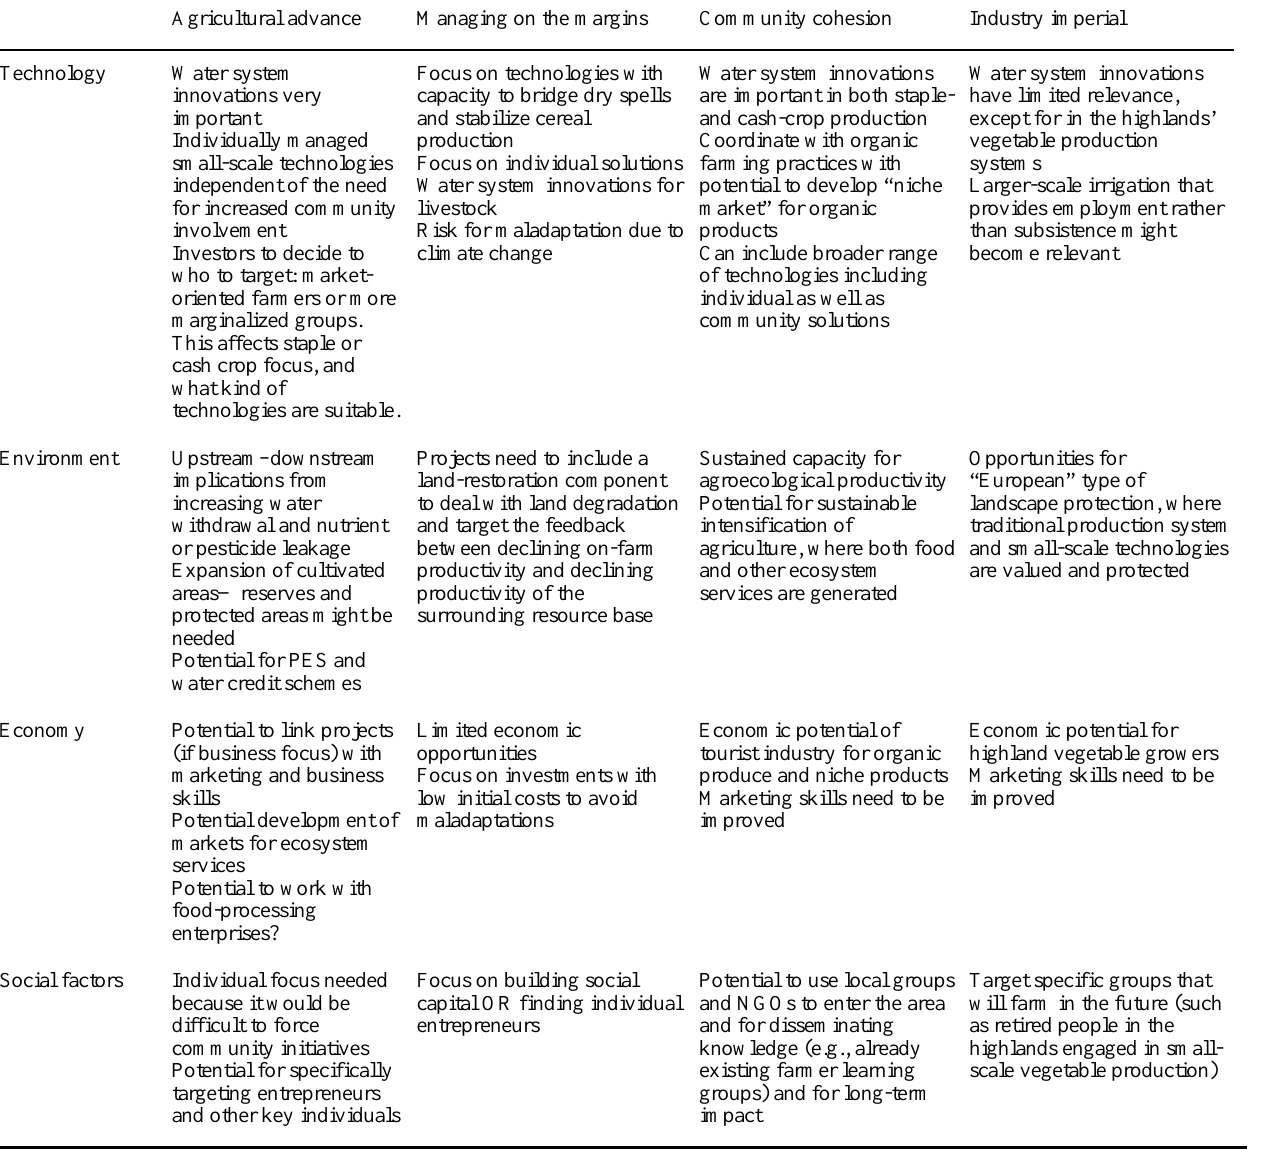
Table 5. Implications for small-scale water system investments in the different scenarios. The table shows some technological, environmental, economic, and social issues that are relevant for successful investments in small-scale water system technologies in the different